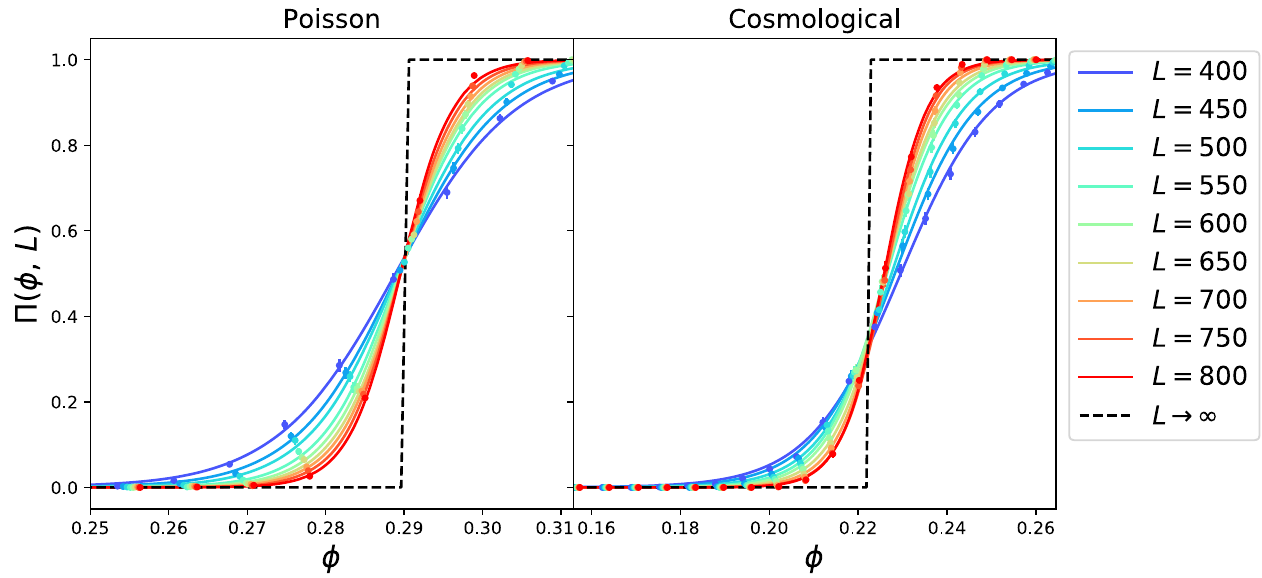
FIG. 10. Percolation probability Π ð ϕ ; L Þ obtained from 1000 QUIJOTE and Poisson simulations, for various nonperiodic box sizes L and volume filling fractions ϕ . This is defined as the fraction of realizations containing a sample spanning cluster, and asymptotes to a Heaviside function centered at the percolation threshold for L → ∞ (shown as a dotted line). Points represent the values computed from simulations, while the solid lines show a fit using the sigmoid function of Eq. (34). Using a finite-scaling analysis, we find the 0 . 252 (0.343) for the QUIJOTE (Poisson) simulations, though we caution that the cosmological result percolation thresholds of η c ¼ depends on the sample